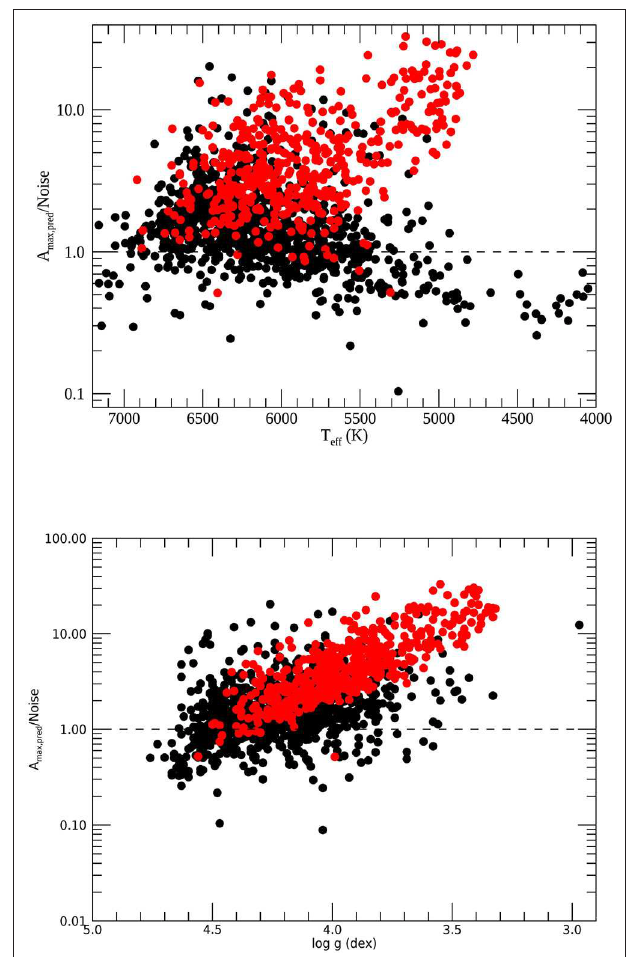
FIGURE 2 | Ratio of the predicted maximum amplitude and the noise at high frequency as a function of the effective temperature (top panel) and as a function of surface gravity (bottom panel) for the stars without detected oscillations (black circles) and the stars with detected oscillations (red